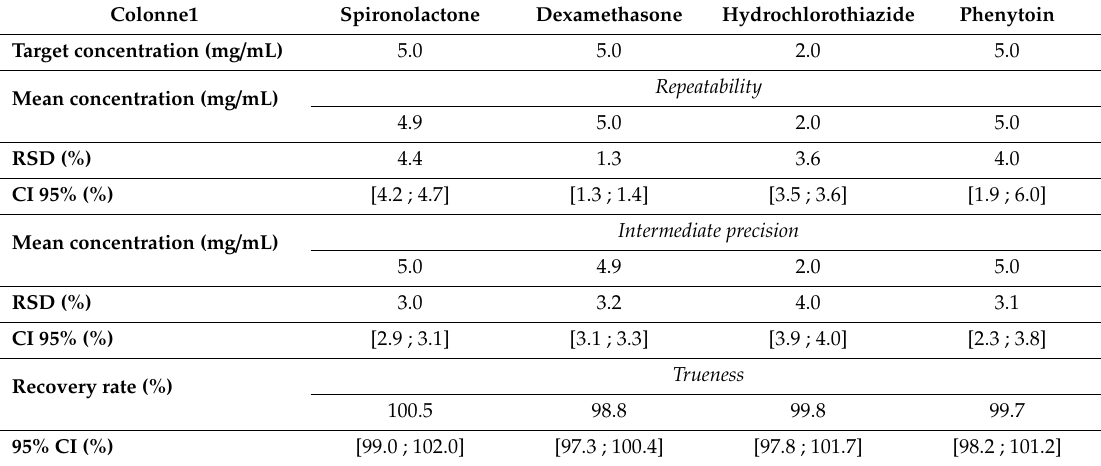
Table 3. Performance parameters obtained during accuracy assessment of the di ff erent analytical methods developed to perform dexamethasone, hydrochlorothiazide, phenytoin, or spironolactone